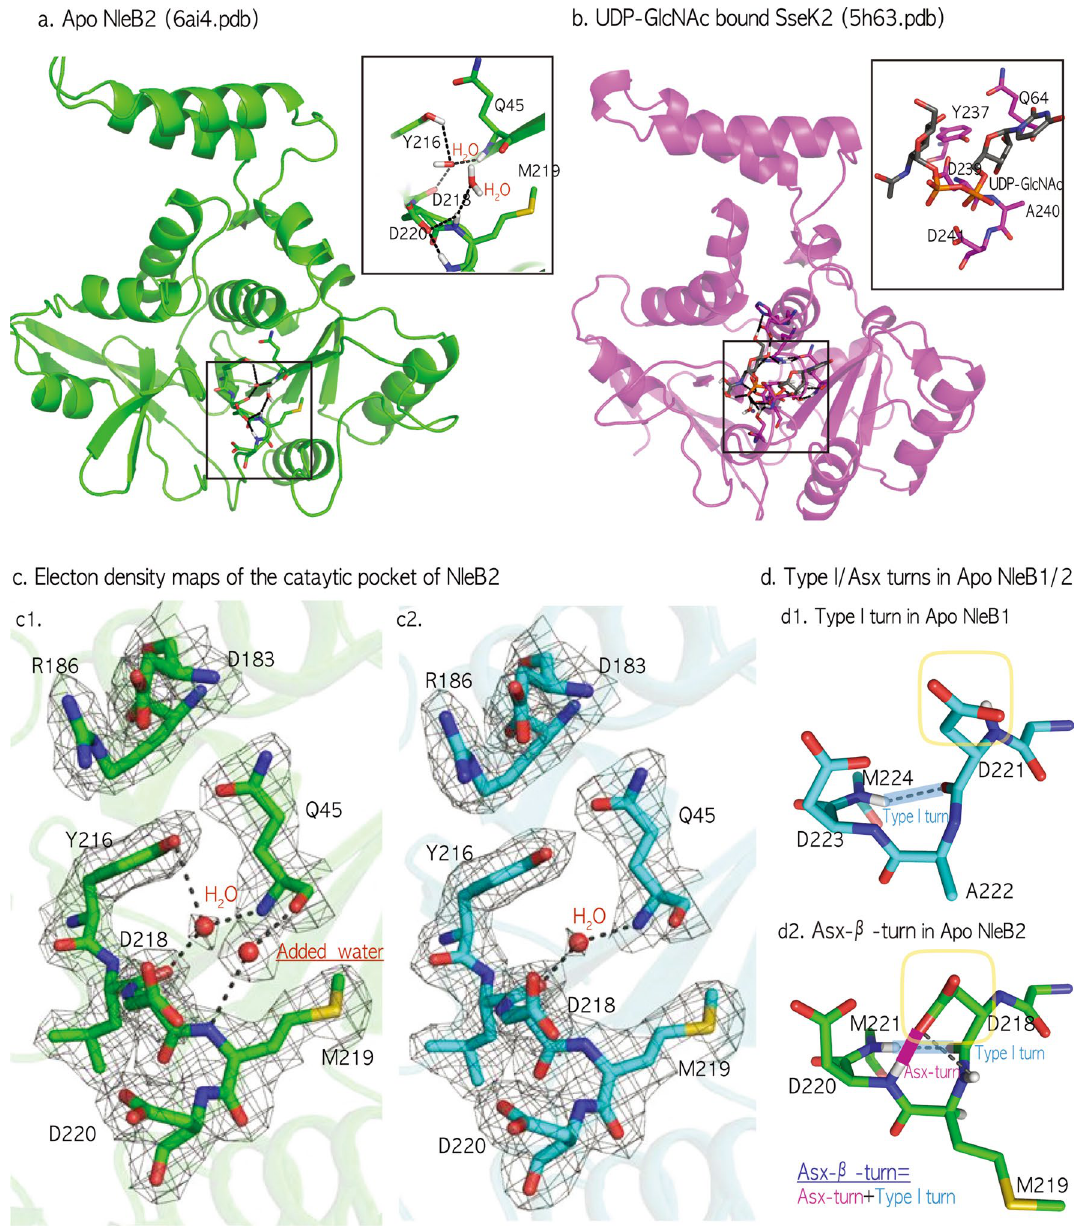
Figure 1. Refinement of the apo NleB2 structure. ( a ) Apo NleB2 Refinement of apo NleB2 (1–316) resulted in better resolution of 2.10 Å from the old 2.30 Å (5H5Y) and showed the detailed network between catalytic cores Q45, Y216, D218, and D220 including three residues Asp218–Met219–Asp220 of DxD motif, comparing with the catalytic pocket of the whole SseK2 in the UDP-GlcNAc bound complex ( b ). ( c ) Electron density maps for a newly oriented water in the catalytic pocket of NleB2. Electron density maps for the DxD motifs of NleB2 and their interacting water molecules of 6ai4 ( c1 ) and 5h5y ( c2 ) 2Fo-Fc electron density maps are contoured at the 1.1σ level (colored gray). Hydrogen bonds are shown as black dashed lines, Q45, Y216, and DMD motifs are represented as sticks and water molecules are depicted as red balls. In the refinement process, we added one water molecule to clarify the connection network among Tyr216, Gln45, and triple residues Asp218-Met219- Asp220 of the DxD motif and confirmed that the new water concretely connects the amino group NH of Met219, the carboxyl group CO of Gln45, the hydroxyl oxygen atom Oη of Tyr216 and one of the carboxylate oxygen atoms Oδ of Asp218 in the electron density map, unlike the previous apo NleB2 (5H5Y). ( d ) The Asx- turn in Apo NleB2 vs . the Type-I-turn in NleB1. The Apo NleB1 DxD motif adopts a Type-I-turn defined by four consecutive residues (221DADM224) and an H-bond between the CO of D221 and NH of M224 ( d1 ) The refined apo NleB2 DxD motif showed that the side chain of the first aspartate Asp 218 in DxD motif makes Asx-turns, combined with another secondary structure Type-I-turn between the CO of D218 and NH of M221, which form an intertwined C10 H-bond network, labeled as an Asx-β-turn ( d2